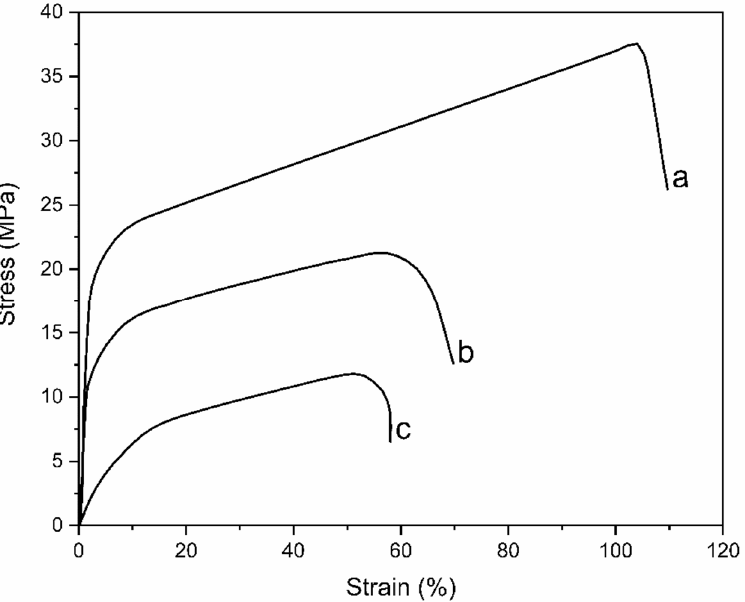
Figure 11. Stress-strain diagrams of: (a) pristine ETFE, (b) ETFE- g -P(4-VP/1-VIm)-grafted film, and (c) PA doped-membrane.